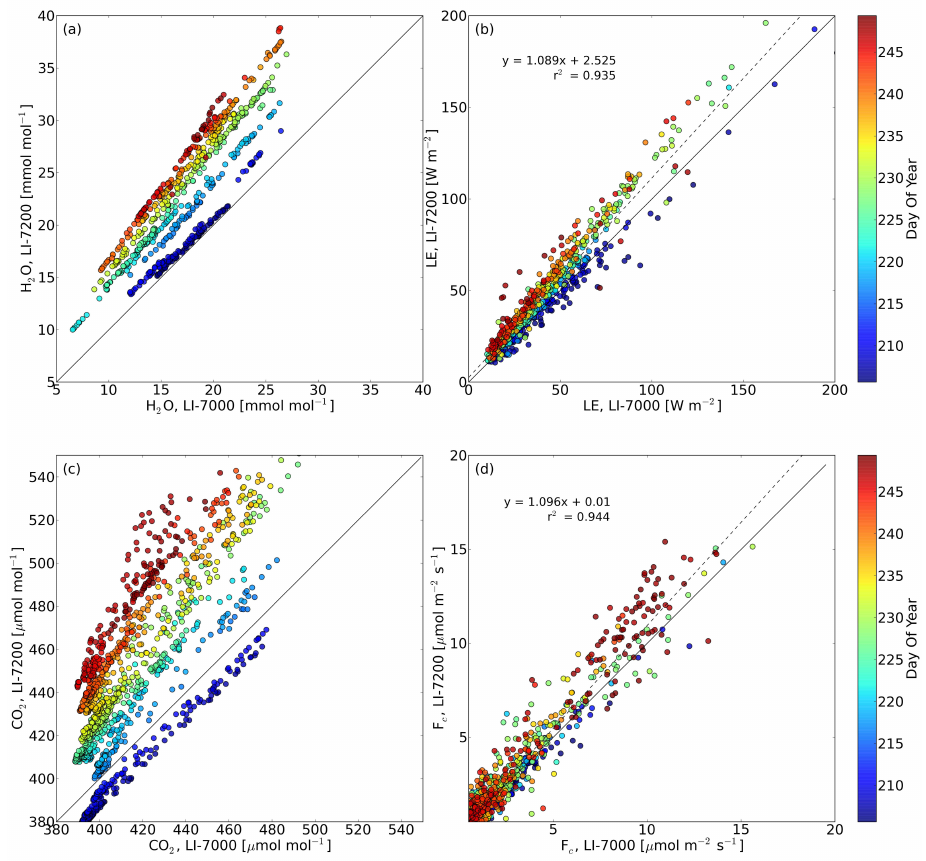
Fig. 6. Comparison of H 2 O (a) and CO 2 (c) mole fractions as measured by the LI-7000 and LI-7200 and corresponding LE (b) and F c (d) values. Colour represents progressing time from the beginning of the